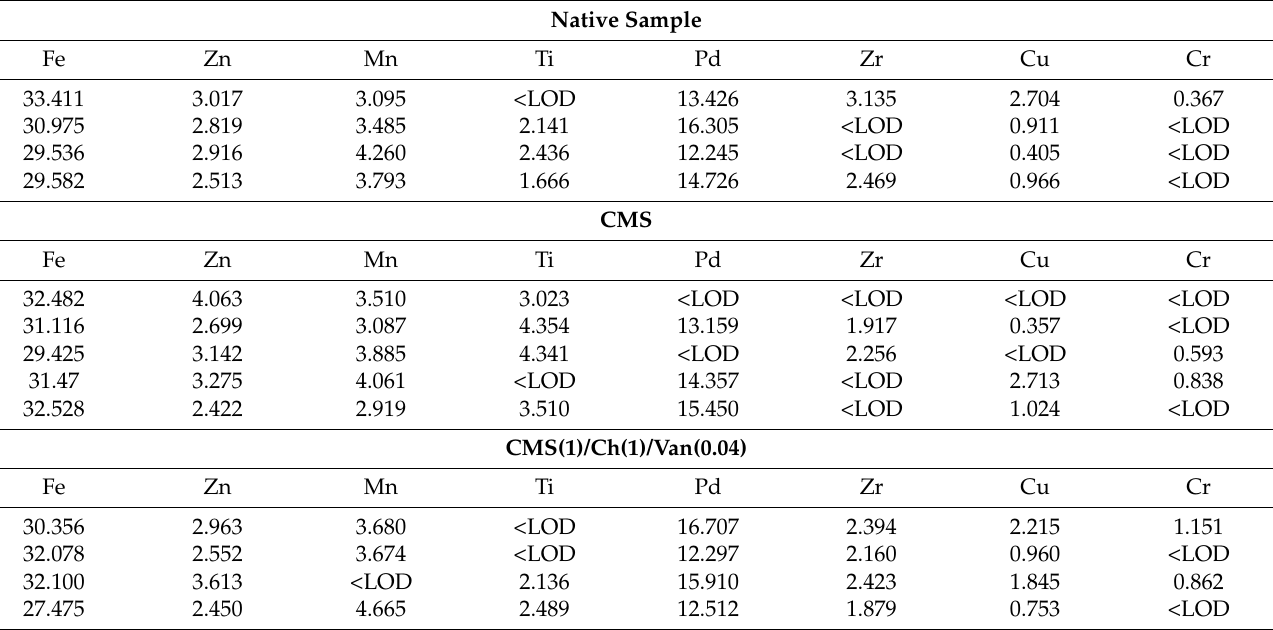
Table 12. The analysis of the Soil elemental composition.